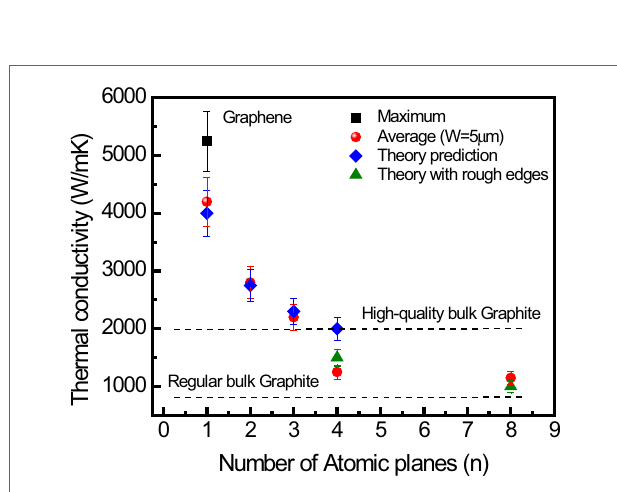
FiGURe 14 | Thermal conductivity with respect to the number for atomic planes of quasi-2D carbon materials . Experimental and simulated thermal conductivity of suspended FLG as a function of number of atomic layer, n, taken at the fixed width, W of the graphene flake. Reproduced with the permission from Ghosh et al. (2010). Copyright 2011, Nature Materials.